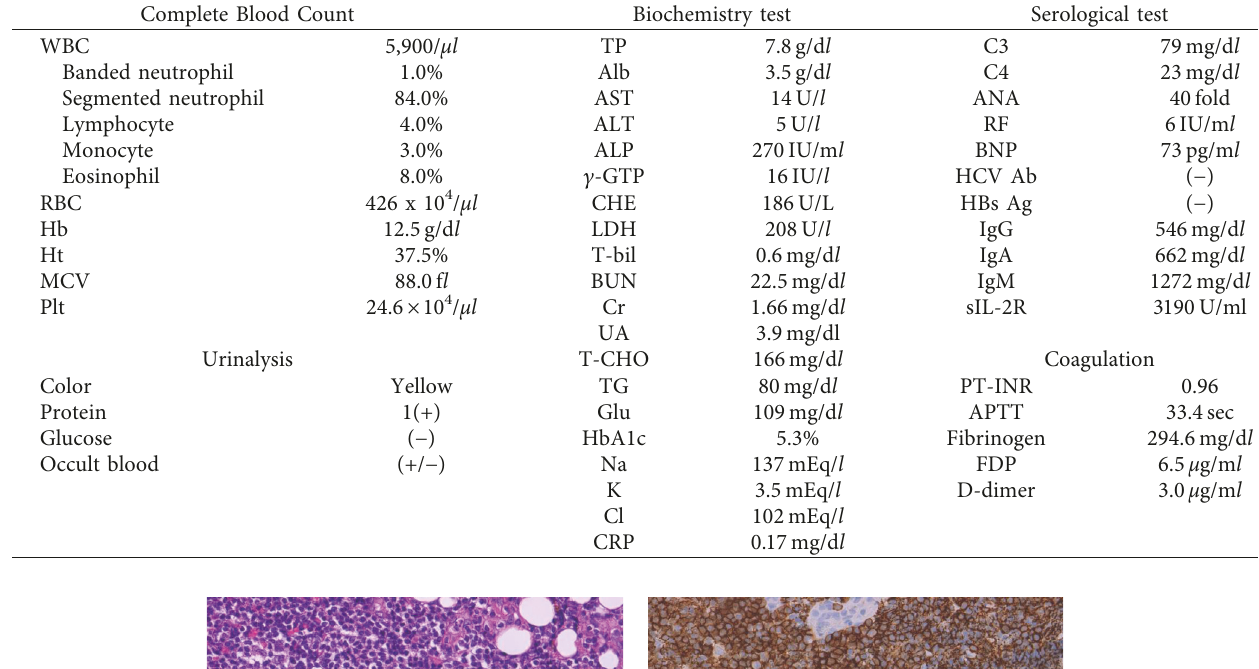
Table 1: Laboratory data on